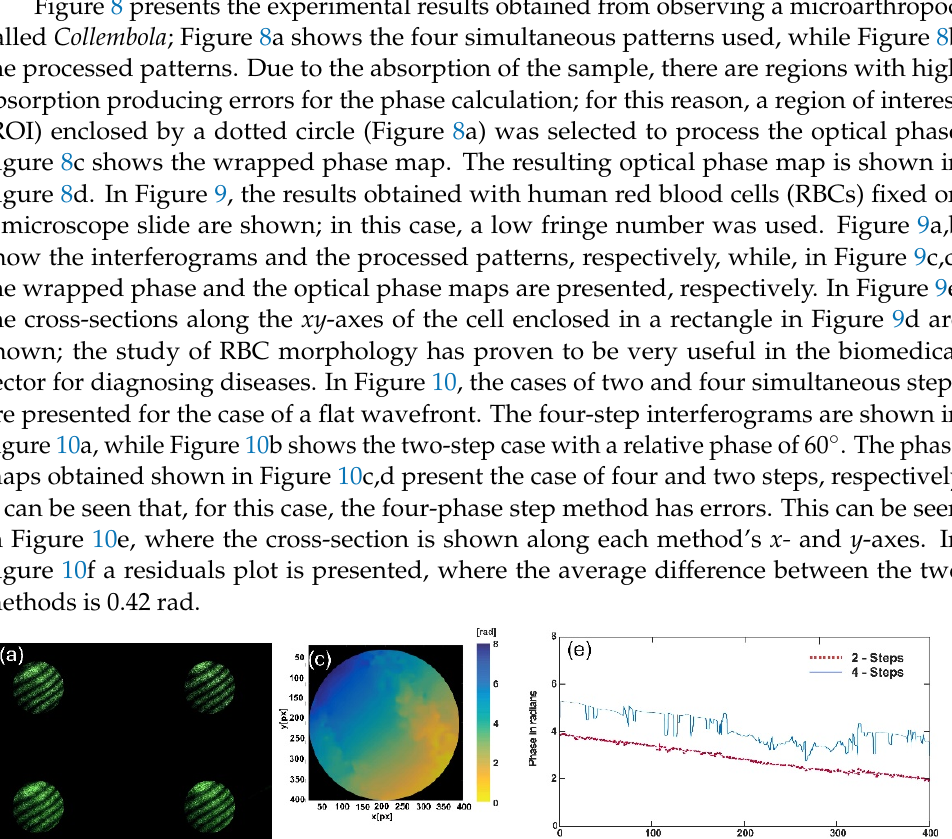
Figure 10. ( a ) Four-interferogram method. ( b ) Two-interferogram method ( c ) Phase map using